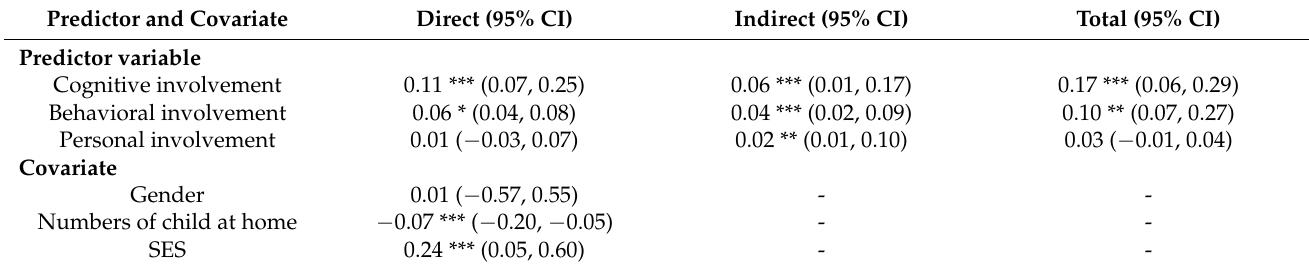
Figure 3. Final model depicting multiple mediation effects of students’ mental health and mathematics self-efficacy between parental involvement and mathematics achievement, controlling for gender, number of children at home, and SES. All coefficients shown are standardized and statistically significant. * p < 0.05; ** p < 0.01; *** p < 0.001. Table 3. Standardized direct, indirect, and total effects for the final model from parental involvement to mathematics